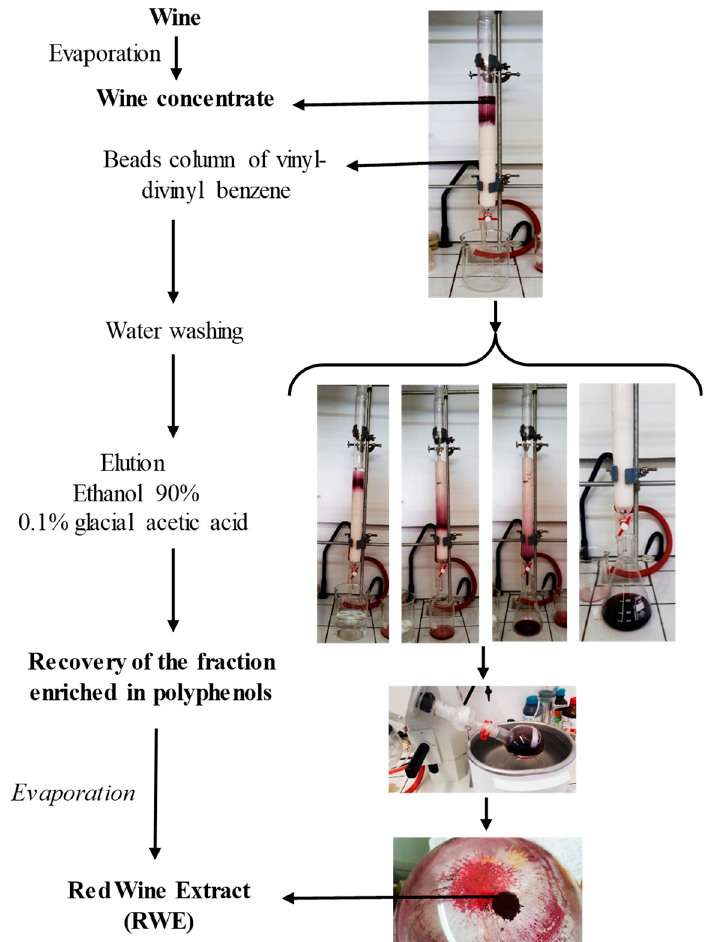
Figure 1. A preparative column was used to adsorb phenolic compounds present in red wine, and after alcohol evaporation, the concentrated residue was lyophilized to be finally sprayed in order to obtain the phenolic extract dry powder.